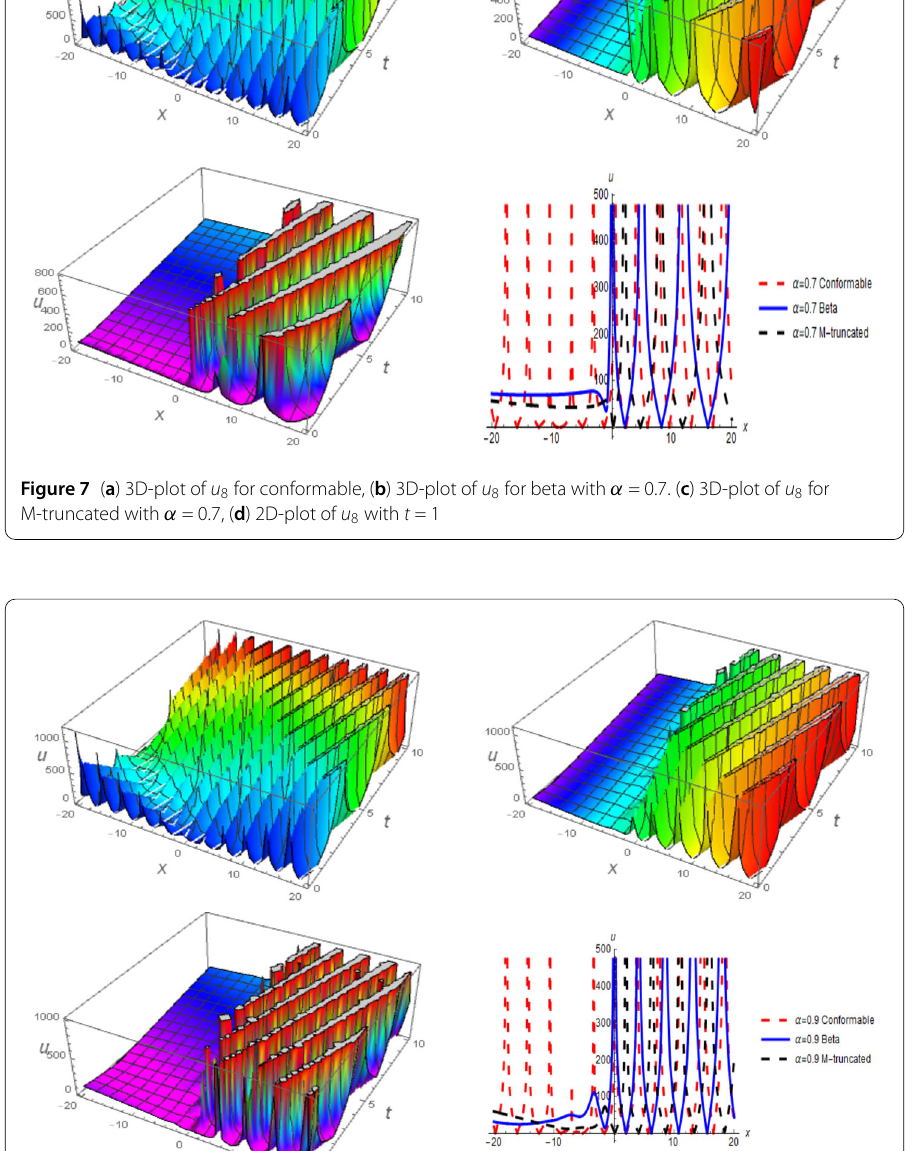
different values of α is presented for t = 1. Here, it is very important to note that the ampli- tude of the soliton’s profile decreases by increasing the value of α in case of three different definitions of